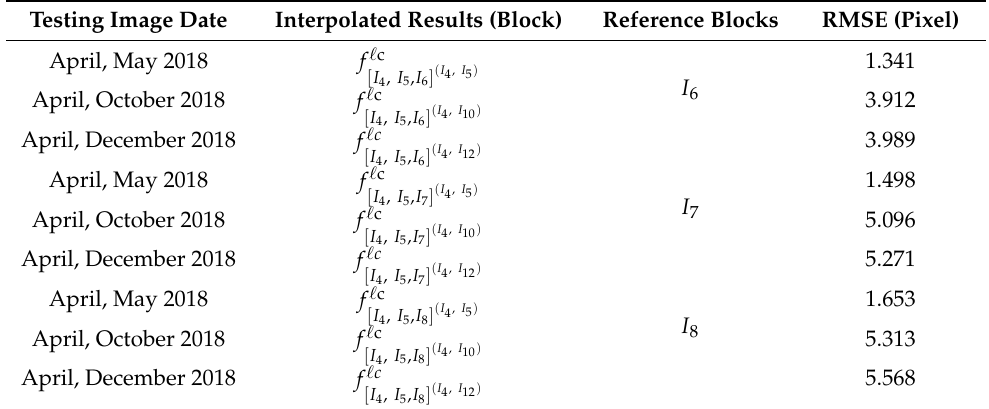
Table 8. Quantitative evaluation between block interpolated result and reference block using different testing block pairs.